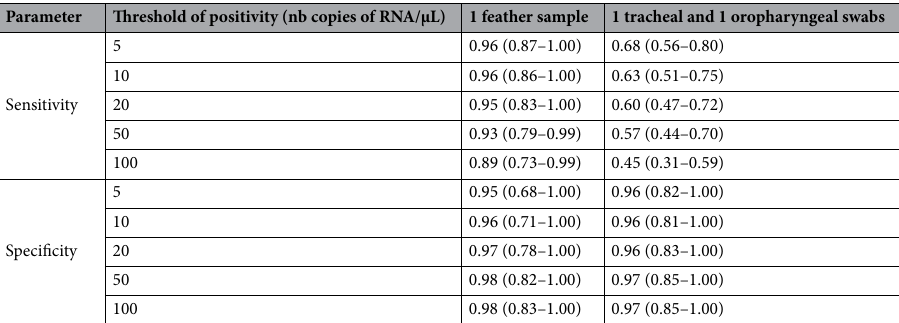
Table 2. Comparison of the detectability of the infection for each threshold of positivity between a sampling strategy involving one feather only and a sampling strategy involving a tracheal swab and an oropharyngeal swab (in which case an animal tested positive is defined by a positive result for at least one of the two swabs). The brackets represent the 95% credible interval of the posterior distributions.